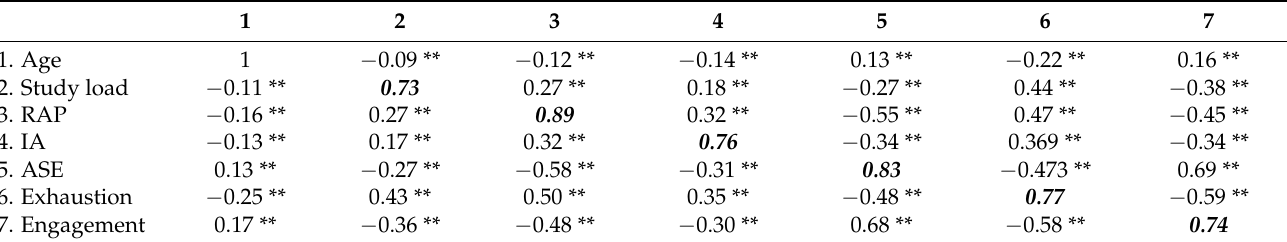
Table 4. Correlation and reliability coefficients of study